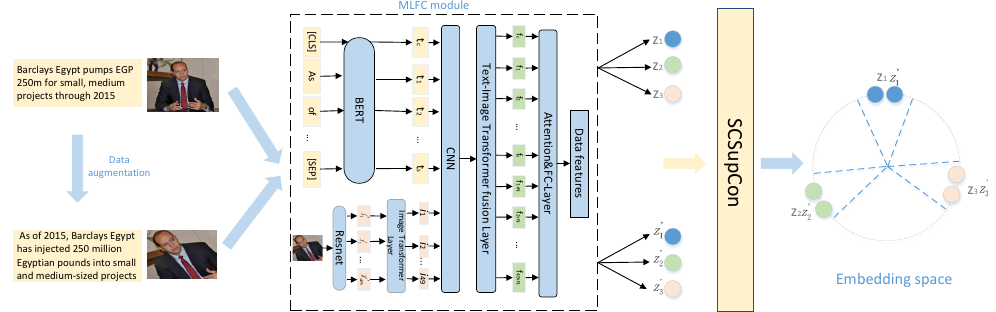
Figure 2. Illustration of our Model overall framework diagram. To judge sentiment polarity, the pro- posed architecture employs supervised contrastive learning and a CNN-connected Transformer fusion. The MLFC module is intended to solve feature extraction and fusion problems in input data. Invariance occurs for graphic sample features when embeddings from the same category, such as z 1 and z ′ . Different categories of graphic features, such as z 1 and z 2 , on the other hand, are far 1